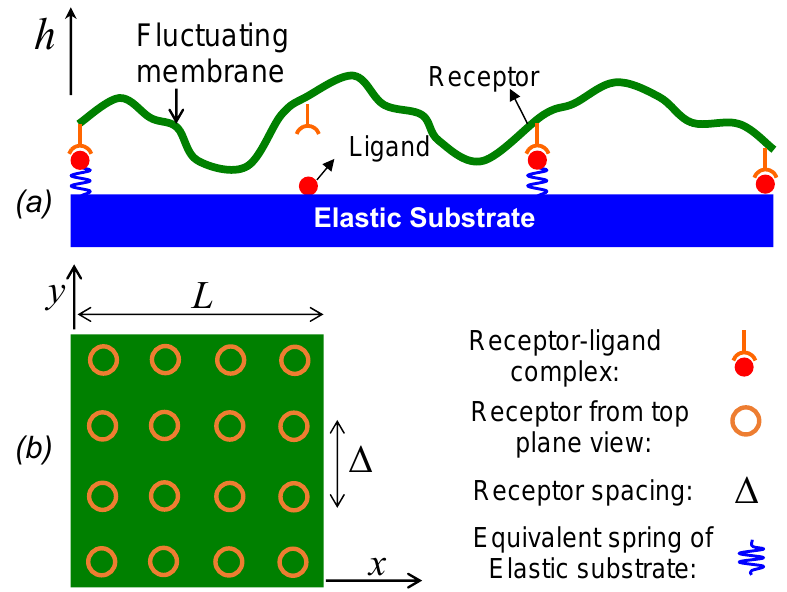
Figure 1. A schematic of a fluctuating membrane adhering to an elastic substrate via ligand–receptor binding: ( a ) side view; ( b ) top view. Note that out-of-plane fluctuation amplitude is exaggerated for better visualization. Structurally, the membrane drawn here includes the glycocalyx layer.